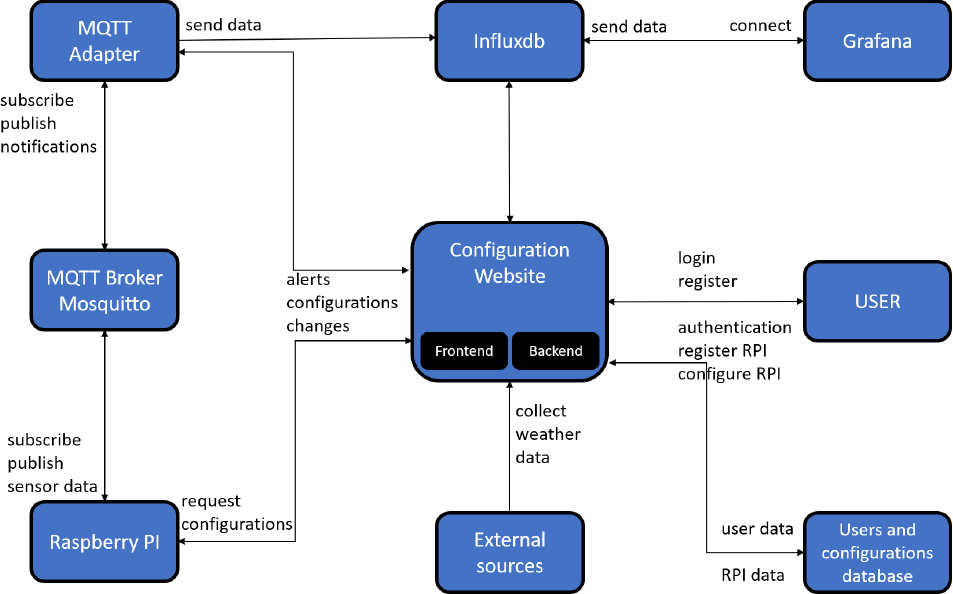
Figure 2. An overview of the architecture with the main blocks and interaction between